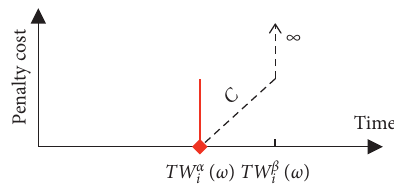
Figure 4: Cost function for delayed